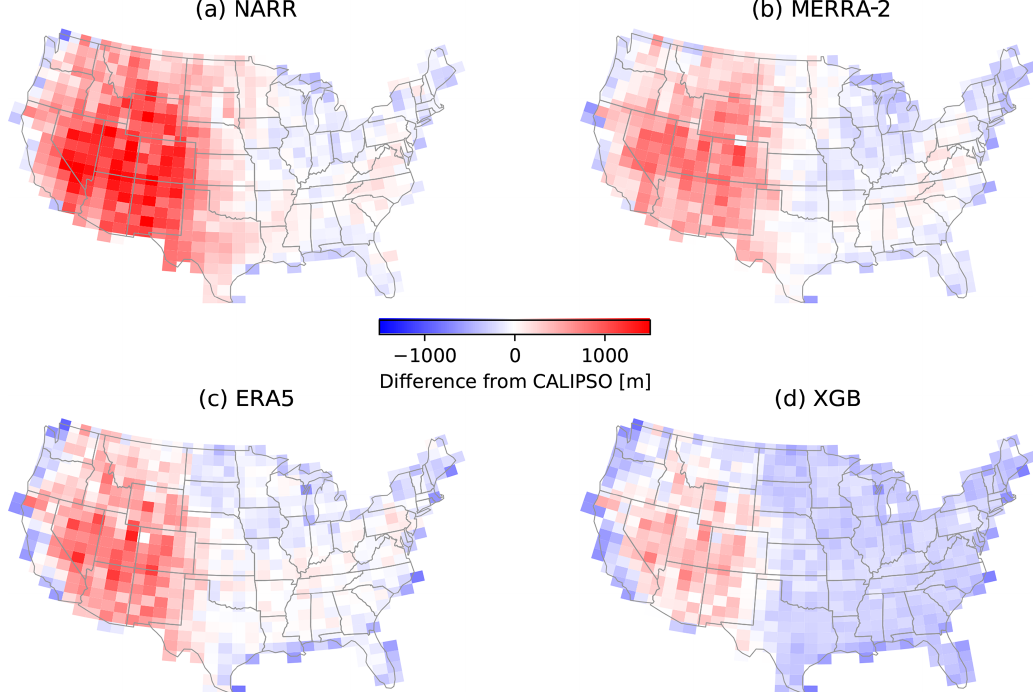
Figure 8. Gridded maps of the mean biases of NARR (a) , MERRA-2 (b) , ERA5 (c) , and XGB prediction (d) relative to CALIPSO for all available soundings of CALIPSO in 2006–2013 with a PBLH between 1 and 2km. The spatial resolution is 2 ◦ × 2 . 5 ◦ .